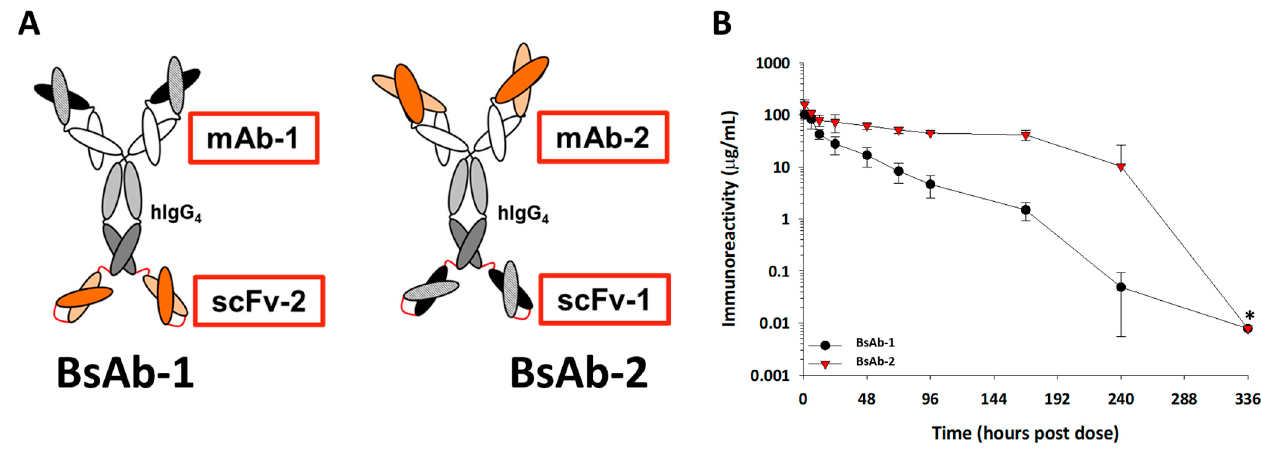
Figure 1. ( A ) Cartoon representations of the BsAb ‐ 1 and BsAb ‐ 2. BsAb ‐ 1 and BsAb ‐ 2 were con ‐ structed with scFv ‐ 2 and scFv ‐ 1, respectfully, covalently linked to the C ‐ terminal end of the HC of the mAb ‐ 1 and mAb ‐ 2, respectfully, using Glycine ‐ Serine linkers (shown in red). The BsAb mole ‐ cules consist of a target binding orientation switch. The Fab region of BsAb ‐ 1 (consisting of mAb ‐ 1) binds to the same ligand as the scFv (scFv ‐ 1) component of BsAb ‐ 2; the Fab region of BsAb ‐ 2 (con ‐ sisting of mAb ‐ 2) binds the same ligand as the scFv ‐ 2 region of BsAb ‐ 1. In the cartoon representa ‐ tion, the dark and light orange structures represent the antigen binding regions of the scFv ‐ 2 and Fab portions of mAb ‐ 2, whereas the dark and light black structures represent antigen binding re ‐ gions of the scFv ‐ 1 and Fab portions of mAb ‐ 1. ( B ) The mean pharmacokinetic profiles of BsAb ‐ 1 and BsAb ‐ 2 following a single 5 mg/ kg IV administration to cynomolgus monkeys. Data are the mean for three animals/timepoint for each molecule. * Excluded from PK parameter calculations animals/timepoint for each molecule. * Excluded from PK parameter calculations due to positive due to positive anti ‐ drug antibody titers. anti-drug antibody